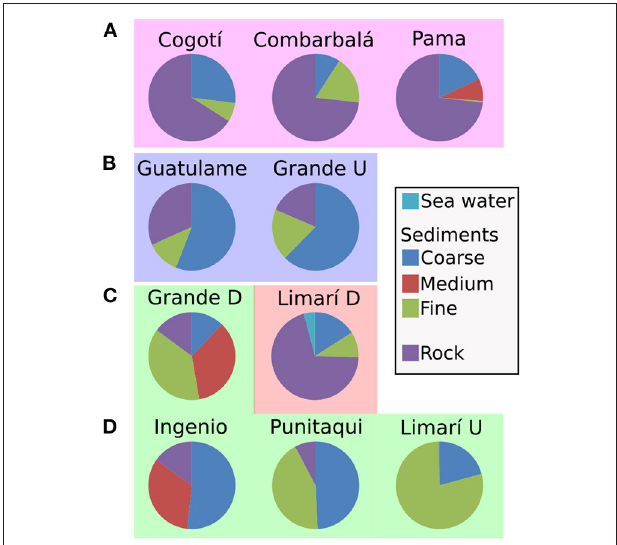
FIGURE 12 | Average material composition for the sectors of hydrogeological continuity. (A) Sectors crossing the Andes mountain range and part of the transversal mountain range. (B) Sectors crossing the transversal mountain range. (C) Sectors crossing the coastal mountain range and the littoral plain. (D) Sectors crossing the pediplanes of the coastal mountain range. The sectors are grouped in shaded boxes according to the color boxes of Figure 4 . Sedimentary deposits are divided according to the grain size: coarse (blocks, gravel and sand), medium (silty sand), and fine (silt and clay). The letters U and D stands for Upstream and Downstream of the element of discontinuity (refer to Section